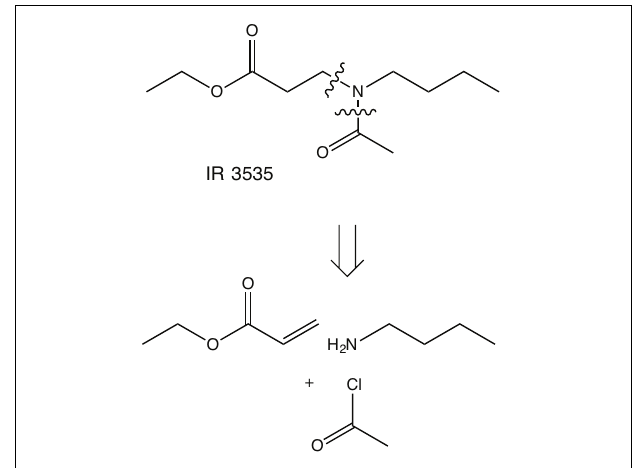
FIGURE 1 | IR3535 backbone related to β -alanine (nature-based backbones colored in green). SCHEME 1 | Retrosynthesis of